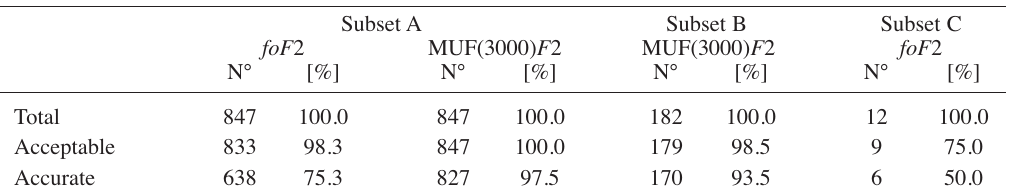
Table IV. Subset A, subset B and ubset C: acceptability and accuracy percentages of autoscaled parameters.